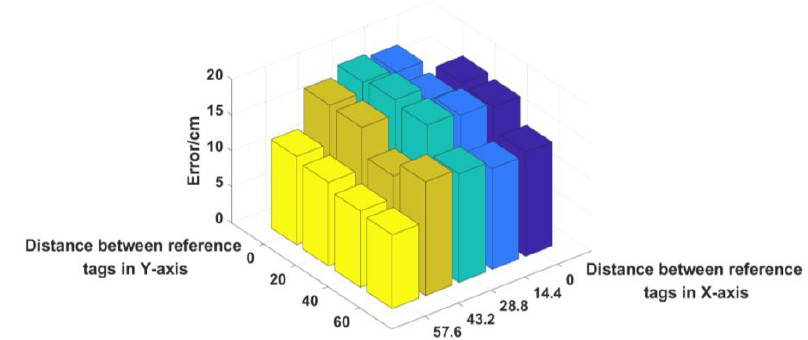
Figure 20. Distance between reference tags vs. Error.